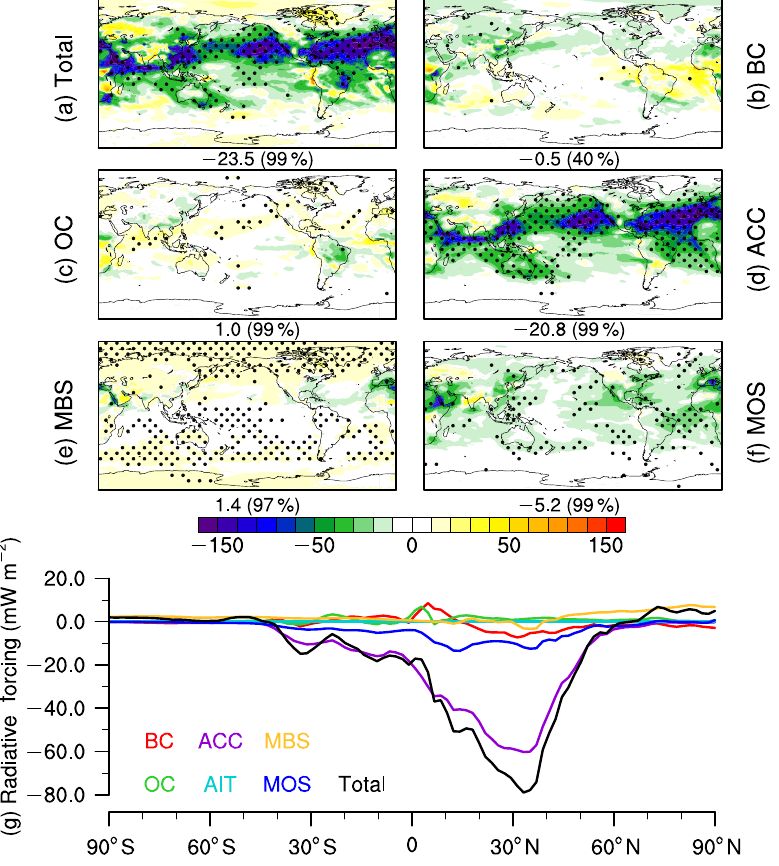
Figure 3. Simulated direct radiative effect (DRE; mWm − 2 ) of ISE at the TOA by MARC. The DRE is calculated as the difference between simulation results with and without ISE (i.e., ShipRef_DMSRef minus ShipZero_DMSRef) and averaged over the 30-year period of simu- lations at all-sky conditions. Panels (a) – (f) show the spatial patterns of DRE due to ISE with the global mean differences and the associated significant levels indicated by the numbers below each panel, and panel (g) shows the meridional variations in zonal mean DRE for various aerosol types from ISE and their total effects. The expansions of the abbreviations can be found in Sect. 2.3. The black dots represent grid points that are statistically significant above the 90% confidence level based on the two-tailed Student’s t